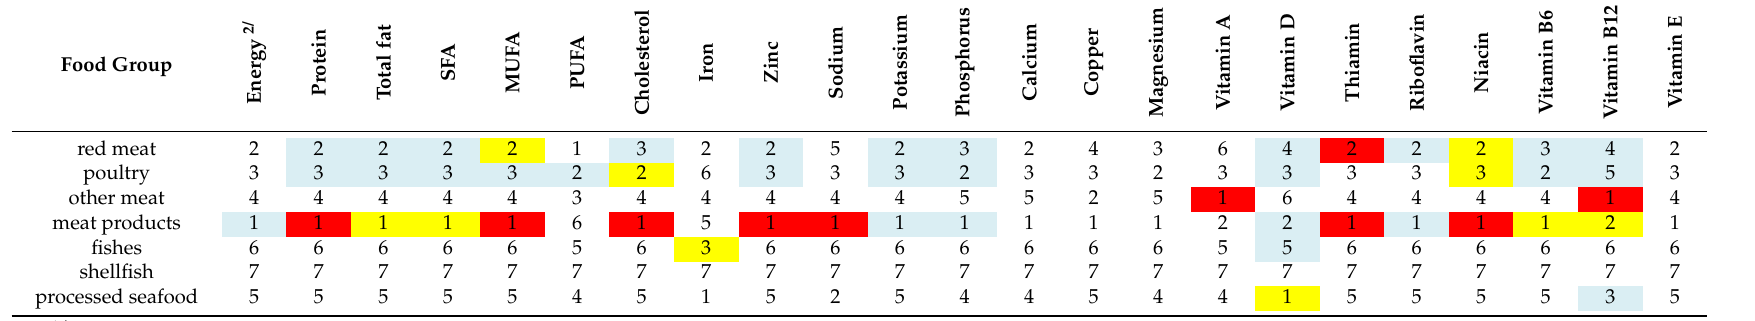
Table 9. Summary: Rankings of food groups as contributors of energy and nutrients 1/ in the average Polish